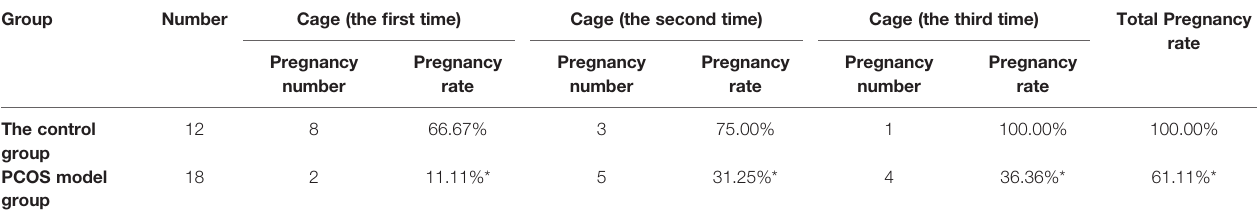
TABLE 2 | The pregnancy rate of the rats.